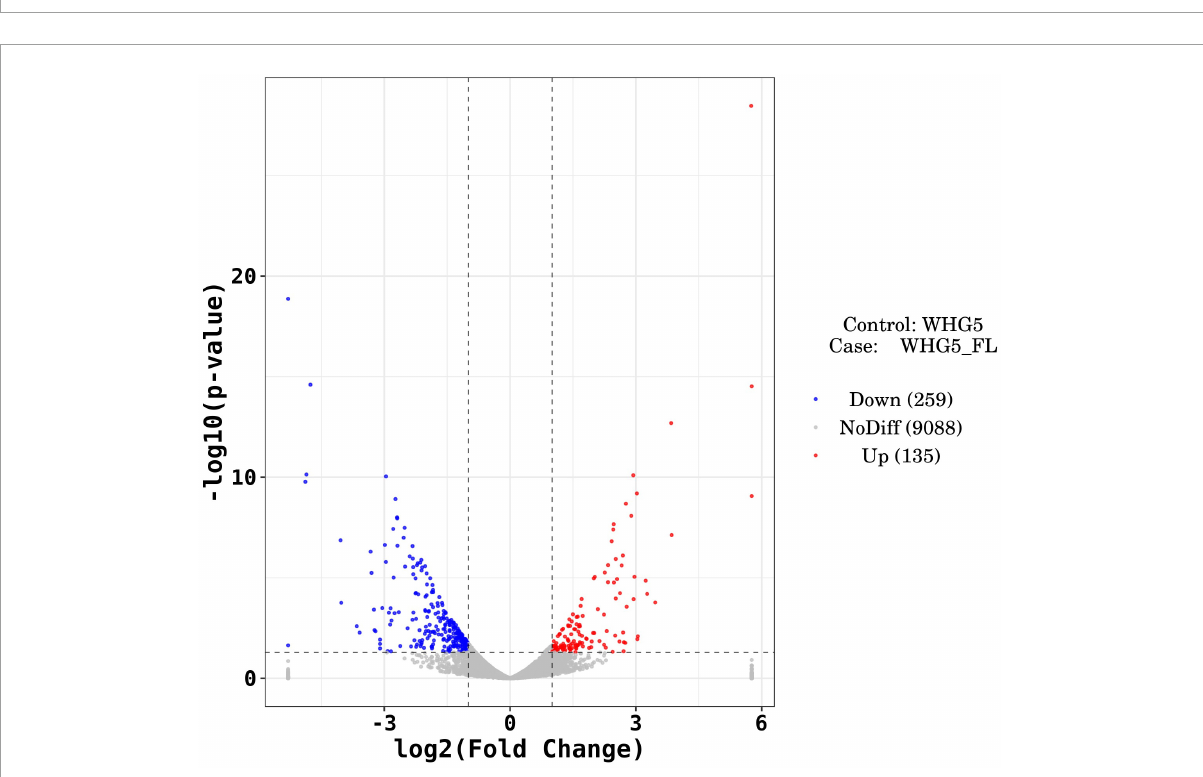
FIGURE4 Differentially expressed genes (fold change > 1) between Penicillium olsonii WHG5 (control; WHG5 cultured without Bacillus velezensis metabolites) and WHG5_FL (treatment; WHG5 cultured with B. velezensis metabolites). Down-regulated genes are in blue, up-regulated genes are in red, and non-differentially expressed genes are in